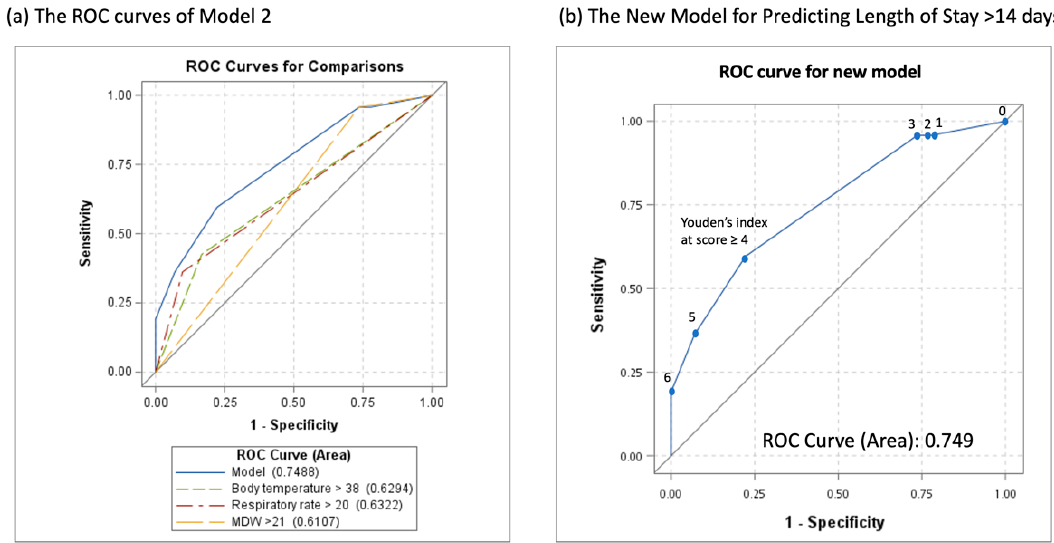
Figure 1. Receiver of operating characteristic curve: ( a ) Model 2; ( b ) the new developed Model 3.